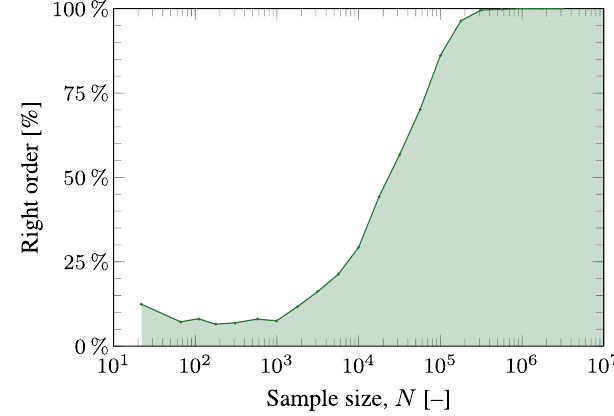
Figure 13. How often five concepts, ranging from 25 to 45mm wall thickness, are ranked in the right order from lowest stress to highest using an aggregation-before-fitting approach with a GEV fitted above a threshold.